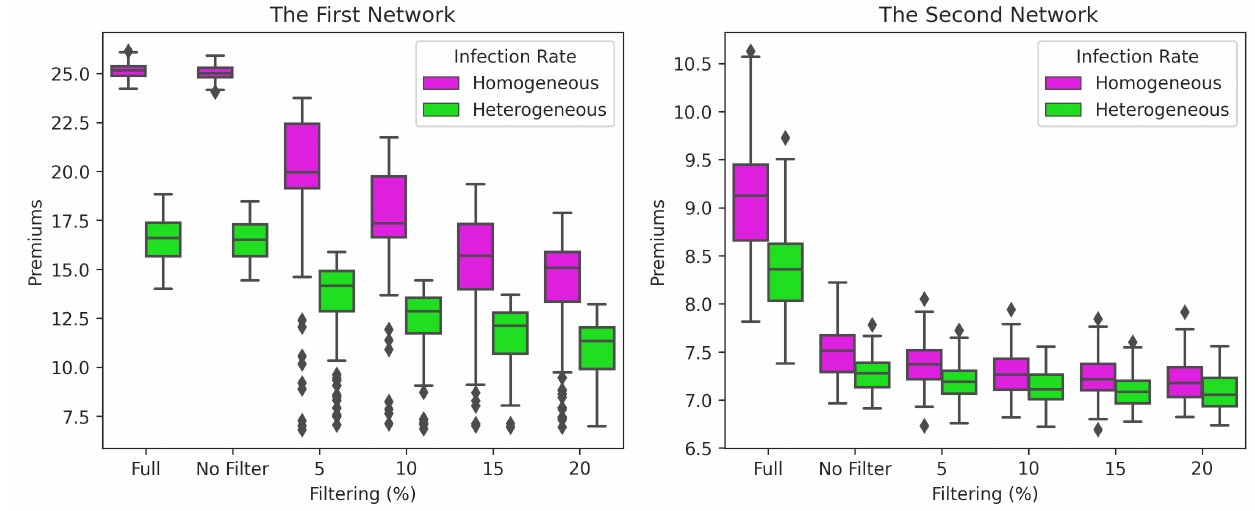
Figure 14. Premiums of nodes based on filters and infection rates in the first and second network. There are two cases for homogeneous and heterogeneous infection rates: (1) without GMA (Full) and (2) with GMA (using filter 0% (No Filter), 5%, 10%, 15% and 20%).